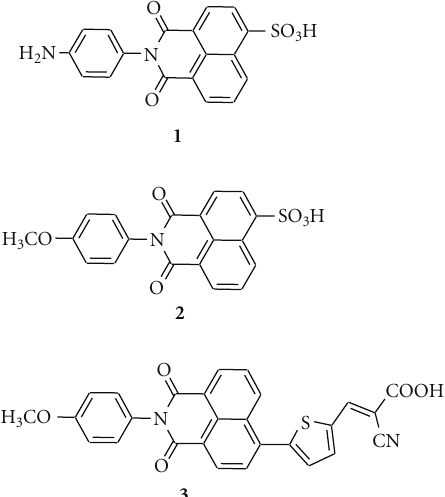
Figure 1: Structures of chromophores of 1–3.